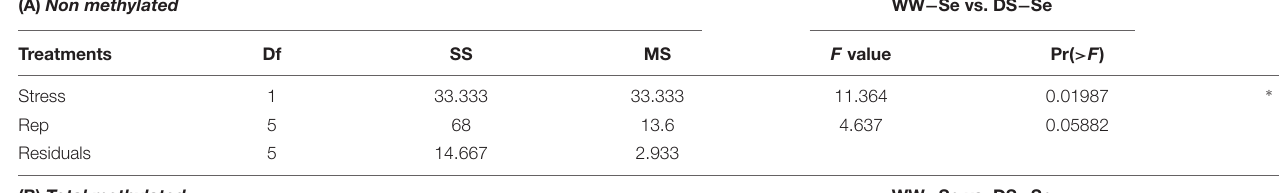
TABLE 5 | Analysis of variance for each different status of methylation (Not-, Total-, Full-, and Hemi- methylated bands) and for each pairwise combination of them considering all the pairwise combinations of stresses (drought stress and Se treatment). (A) Non